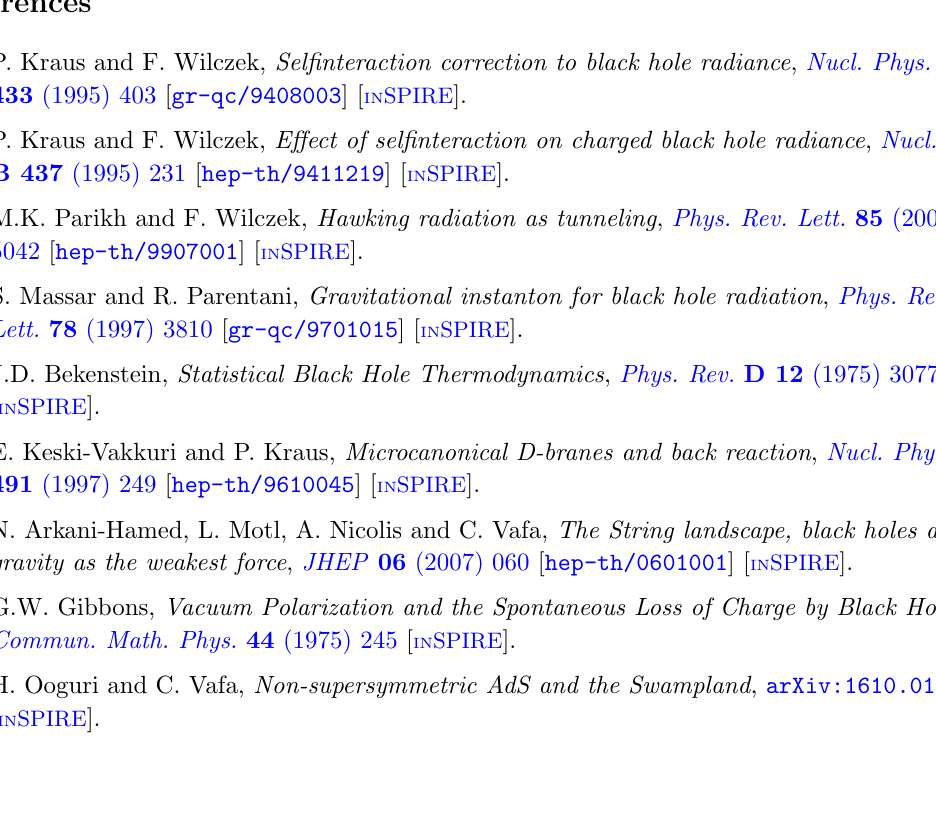
and C 2 vanishes in the limit (cid:15) ! 0 and (cid:15) (cid:15)